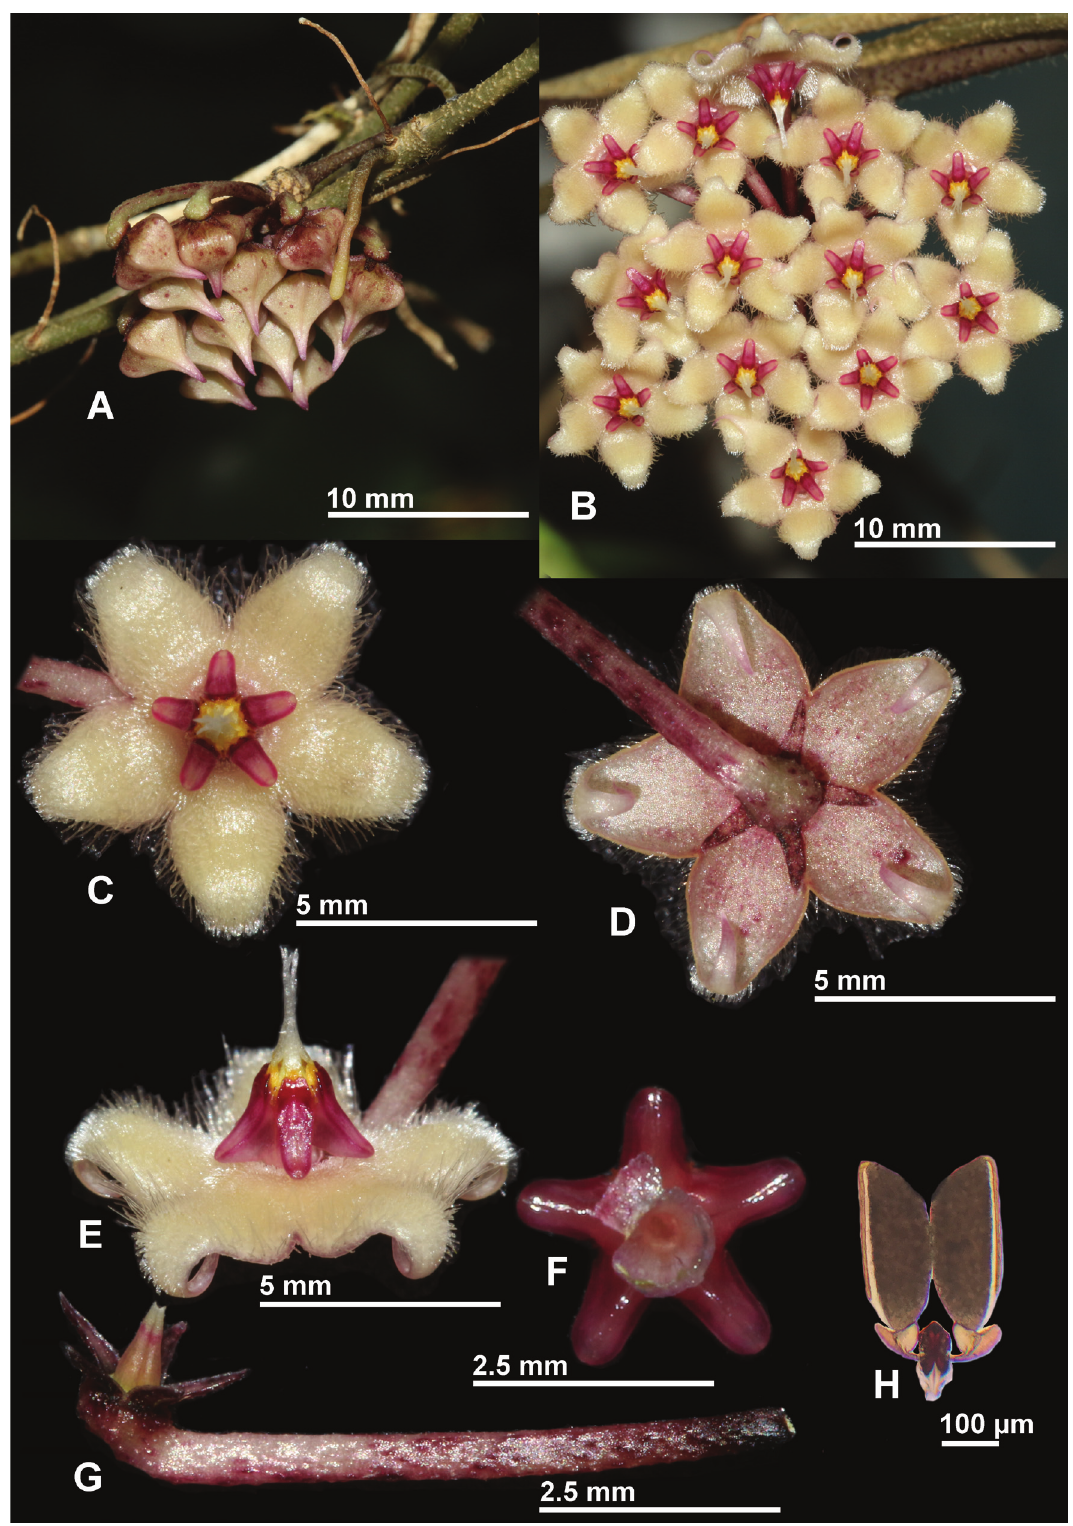
Fig. 3. Hoya sumatrana S.Rahayu & Rodda sp. nov. A . Buds. B . Inflorescence, from underneath. C . Flower, from top. D . Corolla, from underneath, calyx and pedicel. E . Flower, side view. F . Corona, from underneath. G . Pedicel, calyx and ovaries. H . Pollinarium. Photos: M.